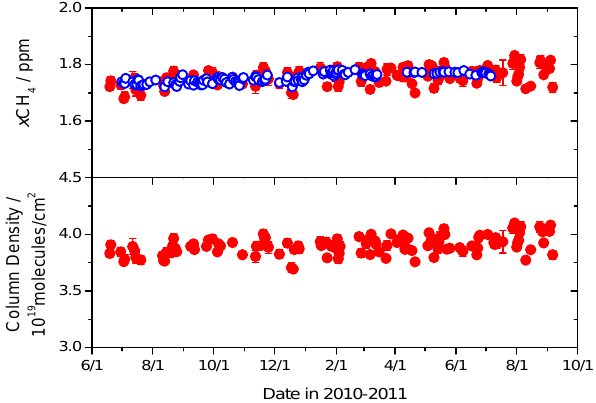
Fig. 4. Time series of column density and x CO 2 with the standard deviations for 14 months at UoW in Australia. OSA: solid circles (SF=1.008); FTS: open circles (SF=0.989). The line in the top panel has a slope of the global growth rate 2.38ppmyr − 1 in 2010.